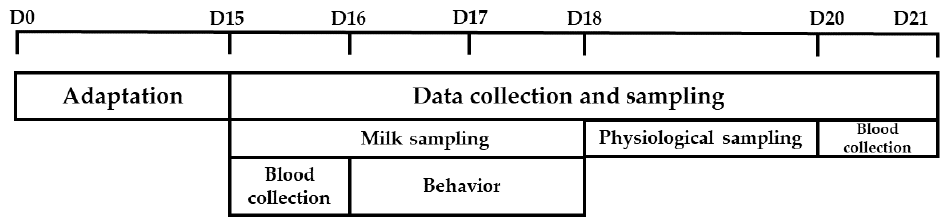
Figure 2. Schematic diagram of the experiment. Milk samples were collected every milking over 3 consecutive days (D15 to D18). Blood collection was performed on D15 and D21. Daily behavior was analyzed on D16 and D17. Physiological variables were collected from D18 to D20.